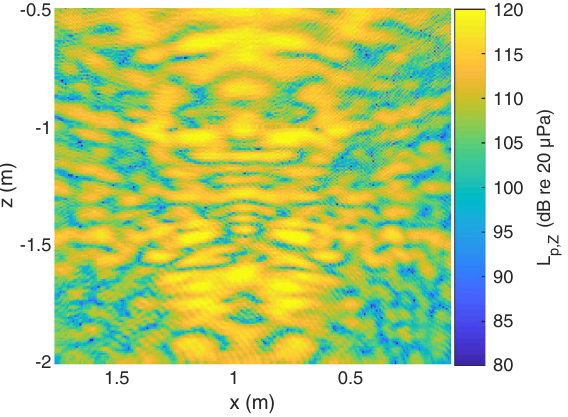
Figure 10. Z -weighted equivalent continuous sound pressure levels time-averaged over 0.64 s L p , Z ,eq 0.64 s of the one-third octave band with a center frequency of 20 kHz in a vertical plane at the back side with a distance of 59 cm to the sonotrode ( S Figure 10 : y = (cid:1) 0.75 m) with a spatial resolution of 0.5